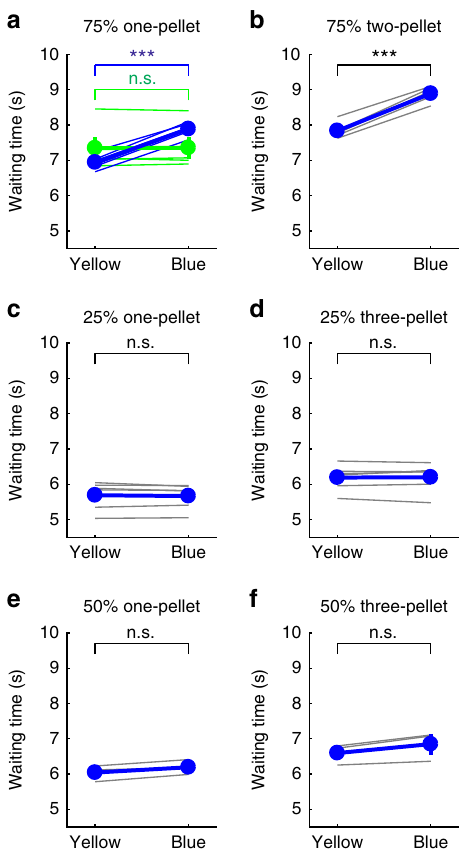
Fig. 3 Average waiting time during omission trials in the 75, 50, and 25% reward tests. a Average waiting time in serotonin no-activation (yellow) and activation (blue) during the 75% one-pellet test for individual ChR2- expressing (blue thin lines) and WT (green thin lines) mice and for population of ChR2-expressing (blue line) and WT (green line) mice. b Average waiting time in serotonin no-activation (yellow) and activation (blue) during the 75% two-pellet test for individual ChR2-expressing mice (gray lines) and for population of mice (blue line). c Average waiting time in serotonin no-activation (yellow) and activation (blue) during the 25% one- pellet test for individual ChR2-expressing mice (gray lines) and for population of mice (blue line). d Average waiting time in serotonin no- activation (yellow) and activation (blue) during the 25% three-pellet test for individual ChR2-expressing mice (gray lines) and for population of mice (blue line). e Average waiting time in serotonin no-activation (yellow) and activation (blue) during the 50% one-pellet test for individual ChR2- expressing mice (gray lines) and for population of mice (blue line). f Average waiting time in serotonin no-activation (yellow) and activation (blue) during the 50% three-pellet test for individual ChR2-expressing mice (gray lines) and for population of mice (blue line). *** P < 0.001 by paired t - test. Error bars represent the s.e.m. In some case, the error bars are too small to be visible. n.s. not signi fi